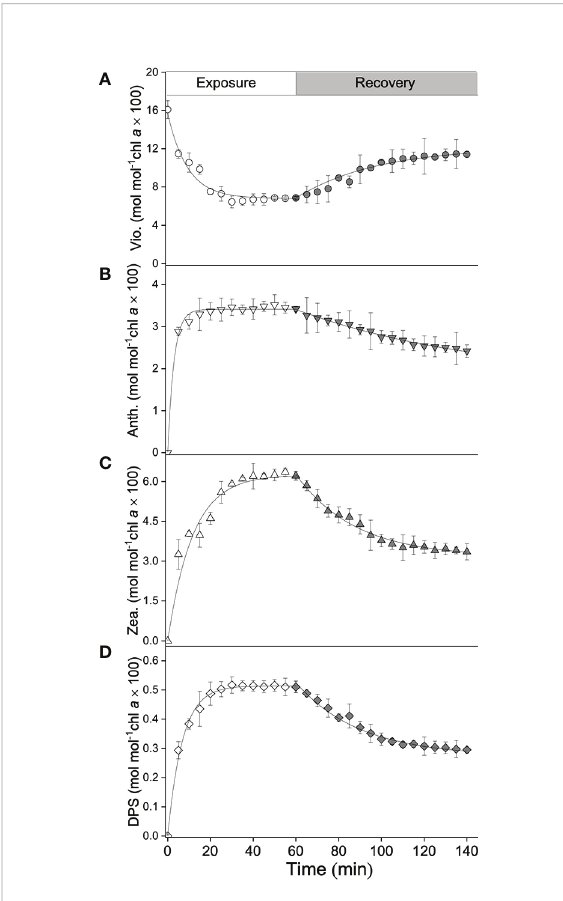
FIGURE 2 Kinetics of xanthophyll cycle pigments of S. thunbergii , including (A) violaxanthin (Vio., mol mol – 1 Chl a × 100), (B) antheraxanthin (Anth., mol mol – 1 Chl a × 100), (C) zeaxanthin (Zea., mol mol – 1 Chl a × 100), and (D) the de-epoxidation state of the xanthophyll cycle (DPS, mol mol – 1 Chl a × 100), during high light exposure for 60 min (1,200 m mol photons m – 2 s – 1 , white points) followed by an 80-min recovery (darkness, gray points). Each curve represents the fi t (all R 2 -values > 0.95) to the model of Ocampo- Alvarez and Garc ı ́ a-Mendoza (2013). Data represent the mean ± SD ( n = 3).